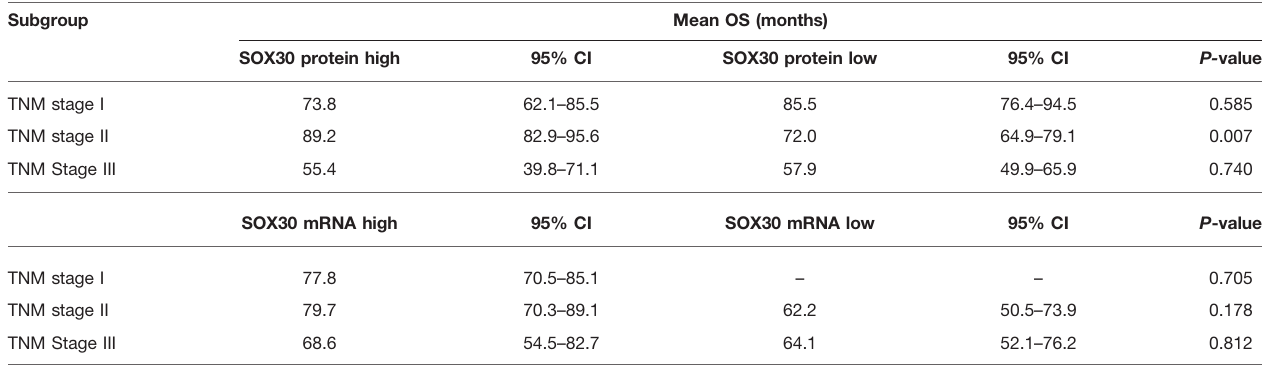
TABLE 3 | Correlation of tumor SOX30 with OS in subgroups categorized by TNM stage.